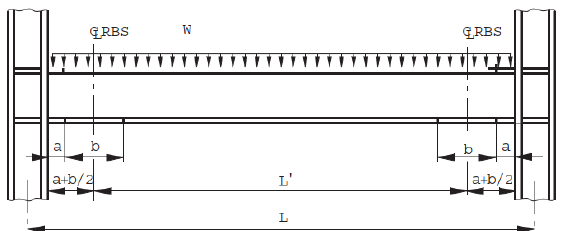
Fig. 3. Typical sub-frame assembly with reduced beam sections (RBS) from